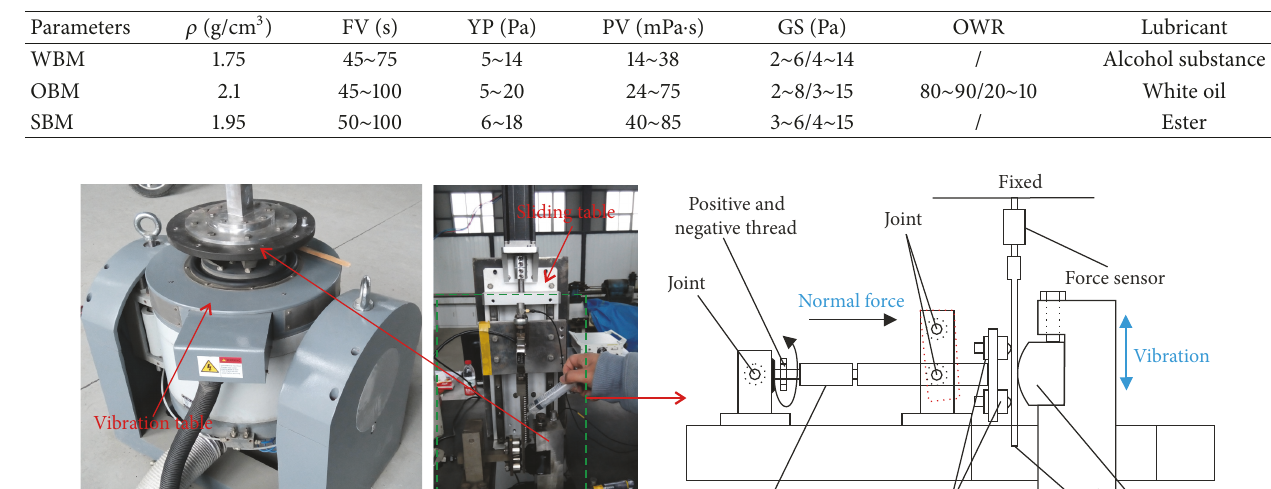
Table 1: Drilling fluid performance parameters.